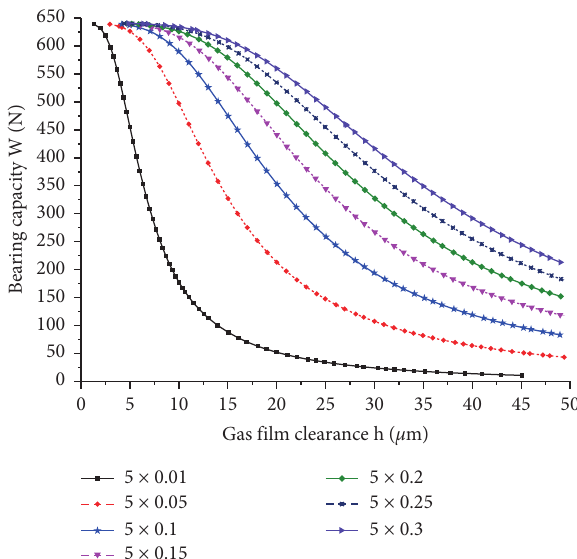
Figure 8: Curve of influence of the diameters d of the orifices on the bearing capacity.